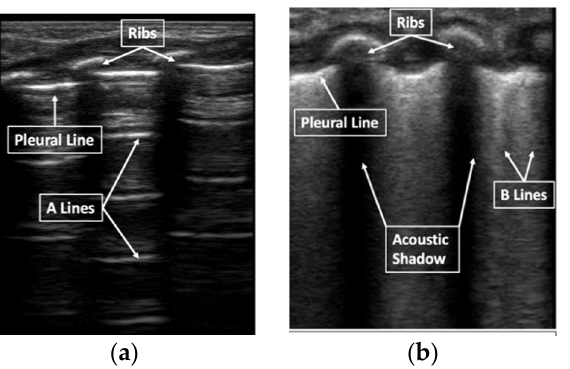
Figure 1. Lung ultrasound artifacts. B-model normal lung ( a ) B-model respiratory distress syndrome ( b ).